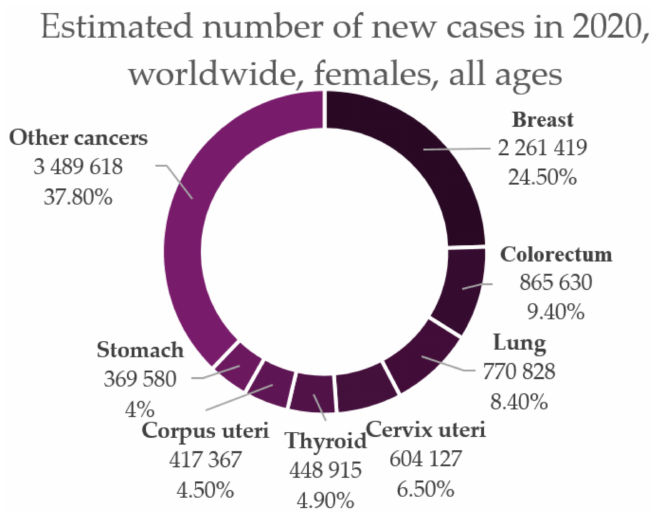
Figure 2. Estimated number of new cases of cancer in 2020 among women of all ages worldwide (adapted after “GLOBOCAN 2020: New Global Cancer Data | UICC.”